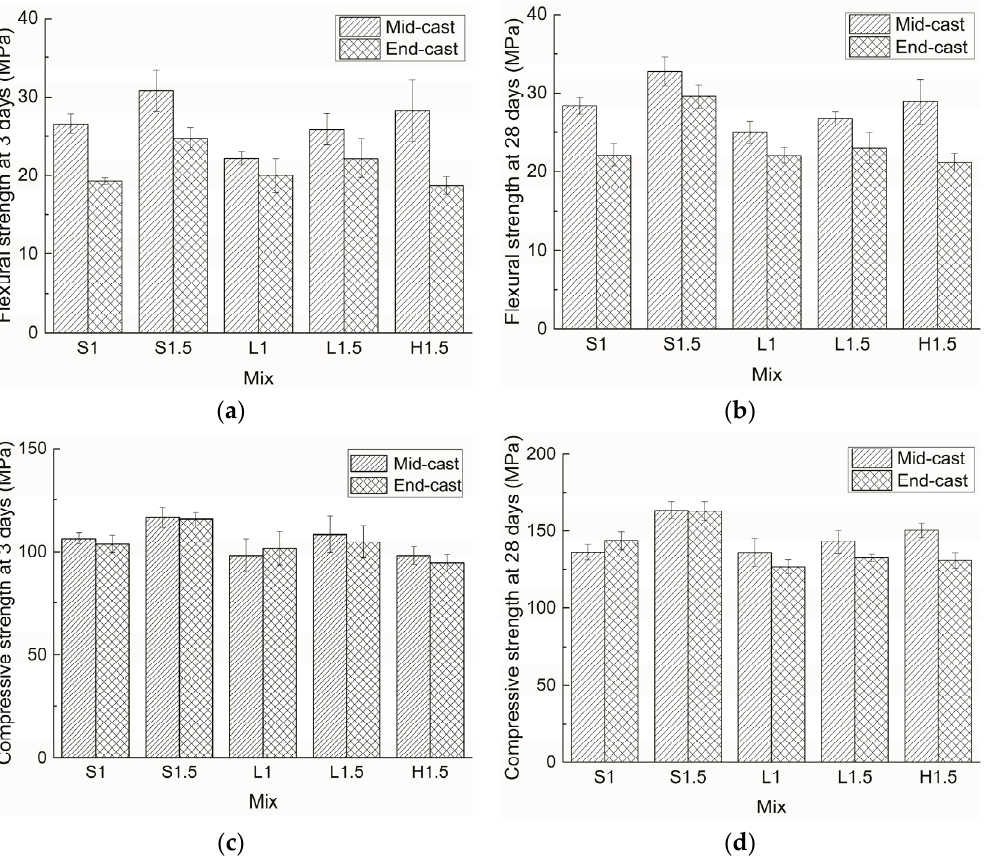
Figure 3. Flexural and compressive strengths of ultra-high performance concrete (UHPC) with two different casting positions: ( a ) flexural strength at 3 days, ( b ) flexural strength at 28 days, ( c ) compressive strength at 3 days, ( d ) compressive strength at 28 days.